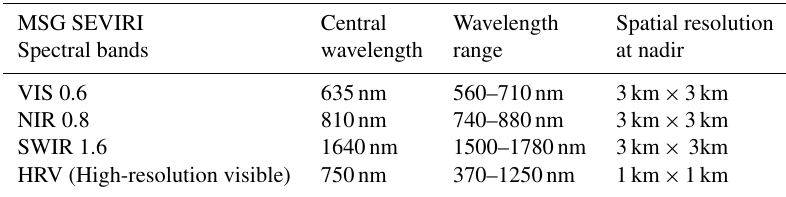
Table 2. MTG FCI solar-reflective spectral bands. MTG FCI Central Spectral Spatial resolution Spectral bands wavelength width at nadir VIS